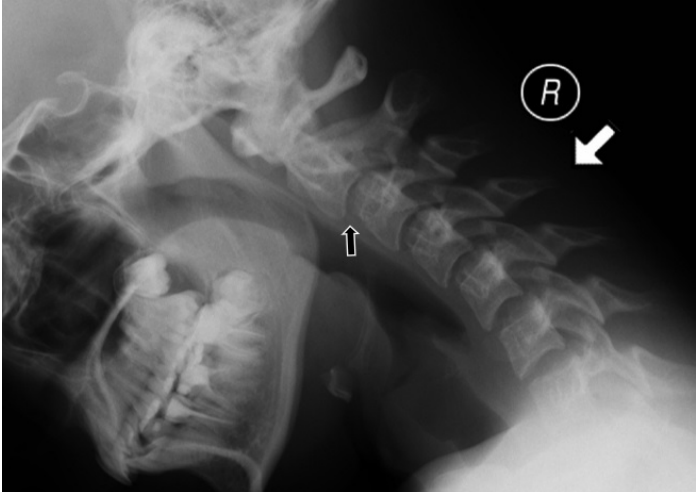
of adjacent vertebrae exceeding 2 mm (Figure 4) [15].